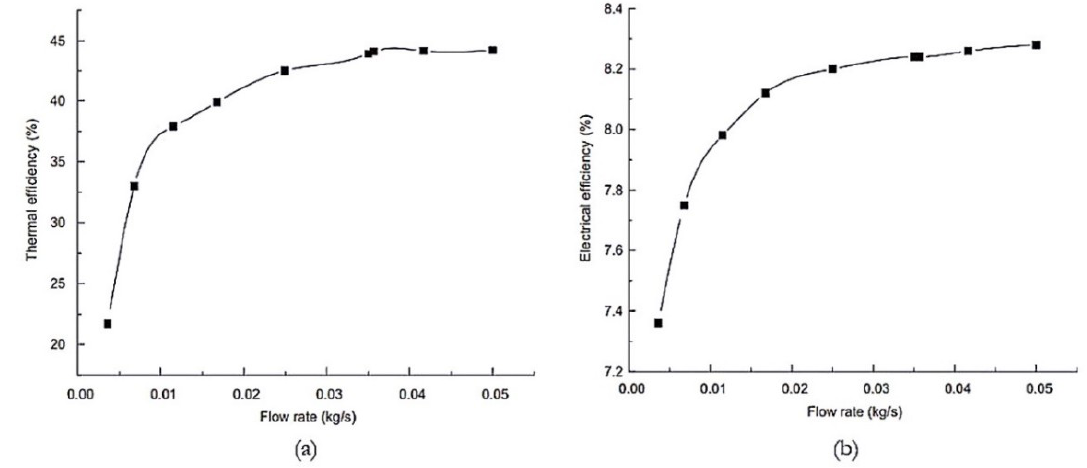
Figure 18. Effect of water flow rate on thermal efficiency ( a ) and electrical efficiency ( b ) [90].